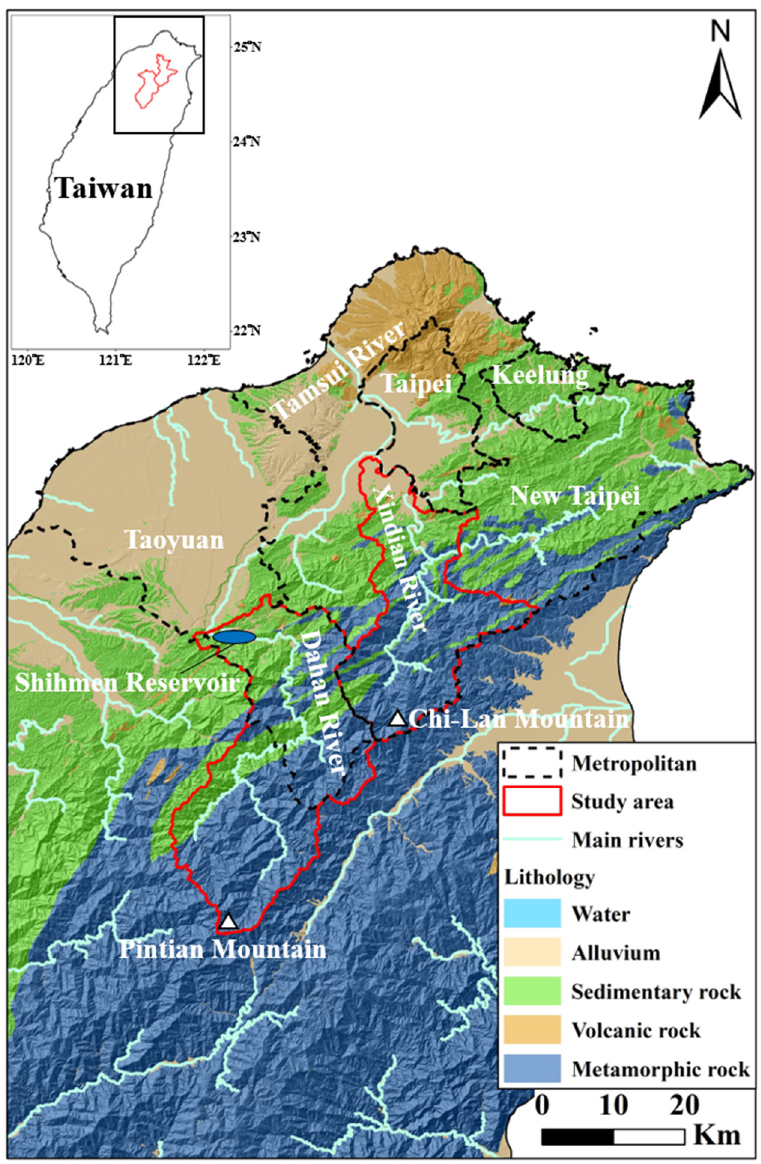
Figure 2. Geographic location of the study area.